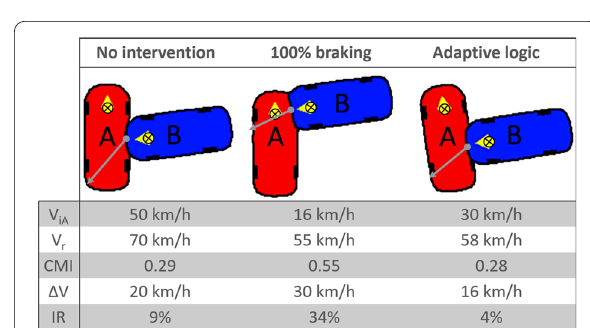
Fig. 7 Impact configurations, (cid:31) V and IR values for a case study extracted from Vangi et al. [42], in case of “no intervention”, “100% braking” (AEB) and “adaptive logic” for an ADAS implemented on board vehicle A (arrows represent the closing velocity vectors, starting from the point of